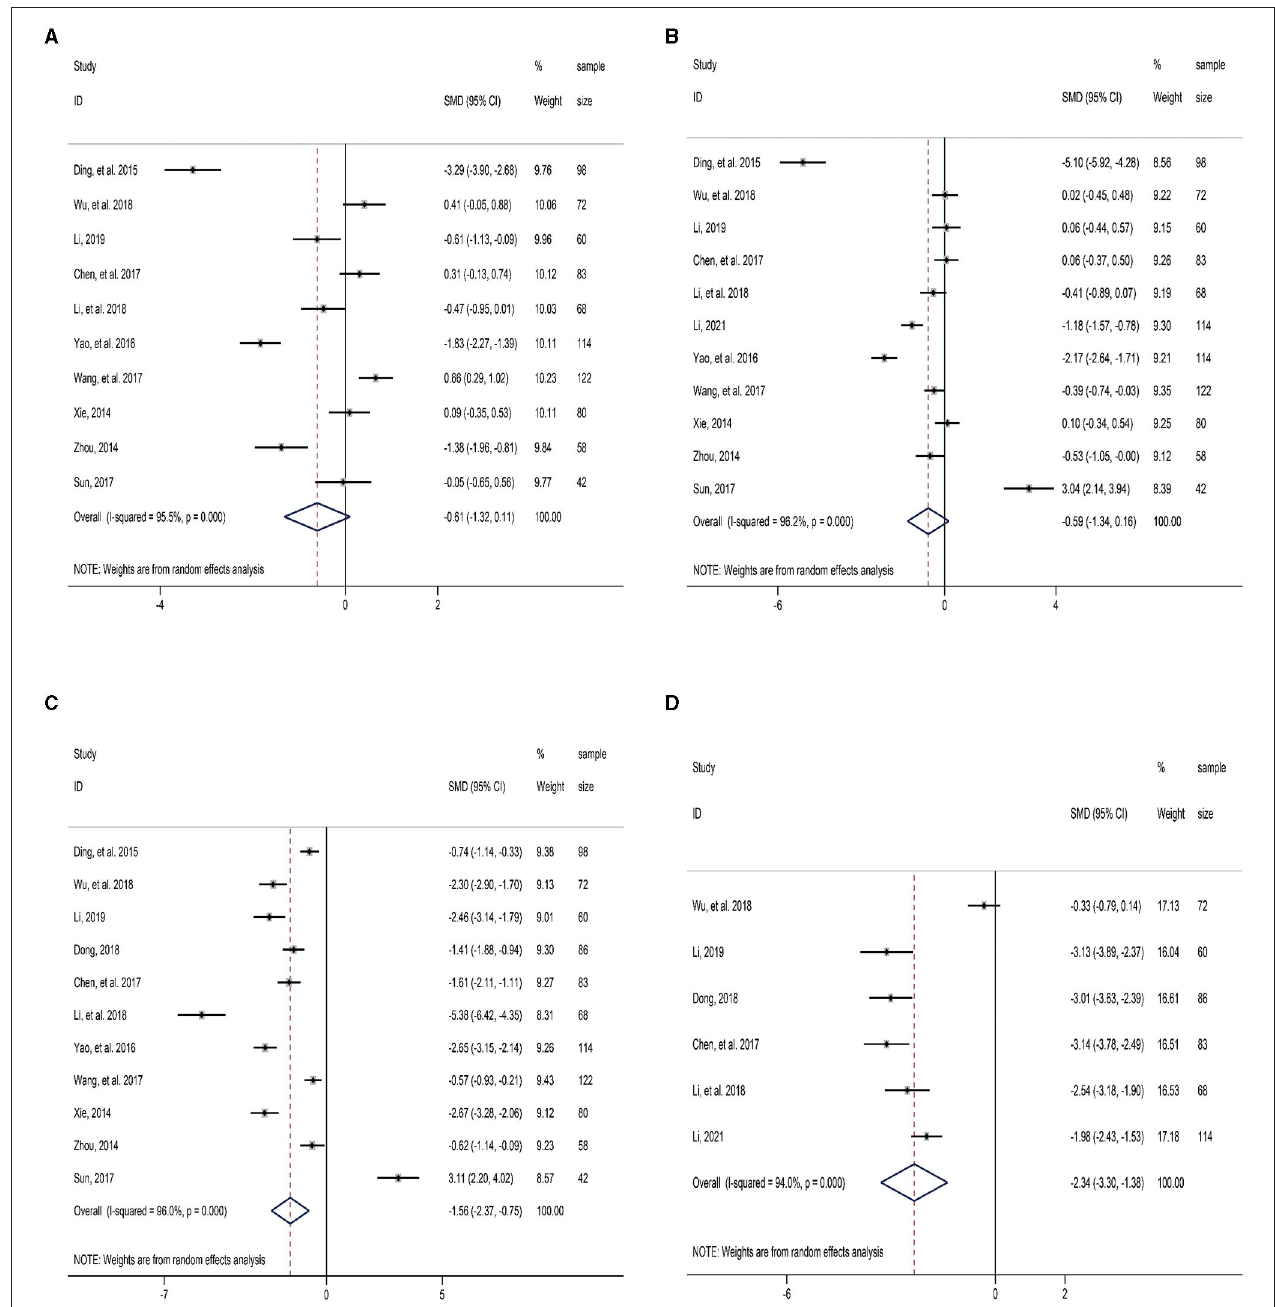
FIGURE 3 | Forest plot of comparison between LLLH and OLLH in hepatolithiasis patients. (A) operation time; (B) intraoperative blood loss; (C) length of hospital stay; and (D) first postoperative